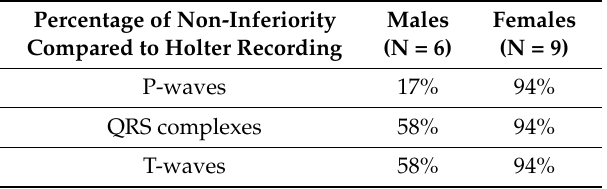
Table 2. Proportion of noninferiority of ECG signal quality of OMgarments.